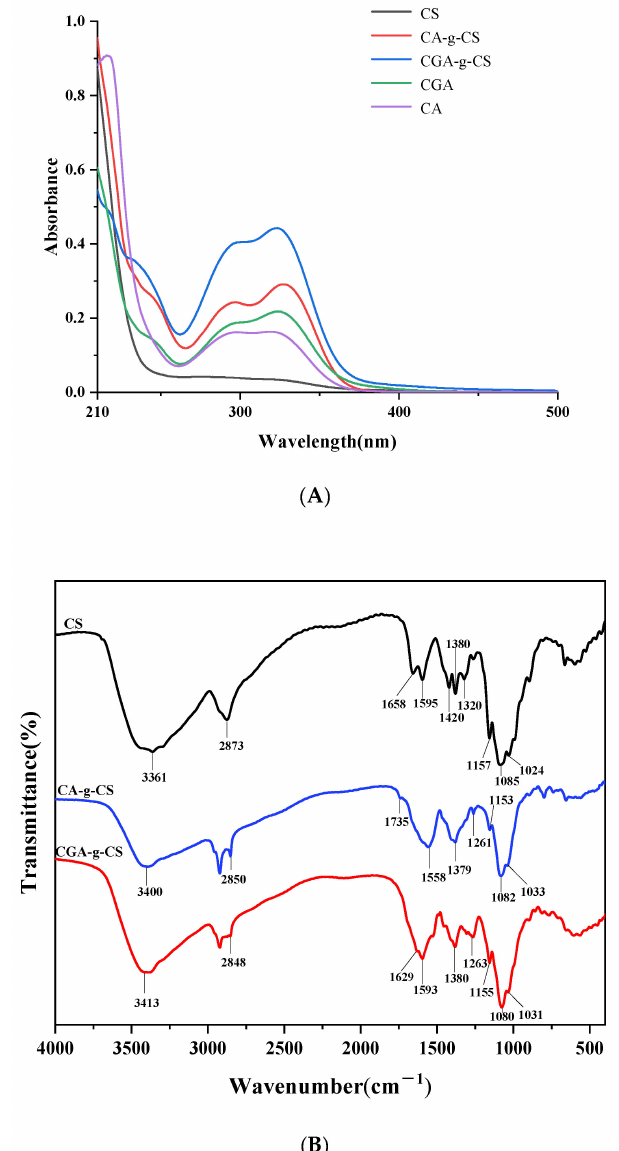
Figure 1. UV–Vis spectra of CS and phenolic acid-CS ( A ); FT-IR spectra of CS and phenolic acid-CS ( B